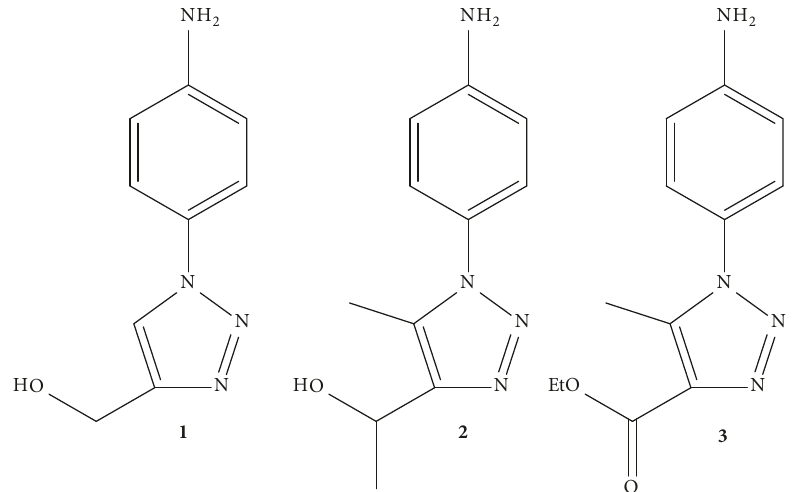
Figure 1: 1,2,3-Triazole derivatives